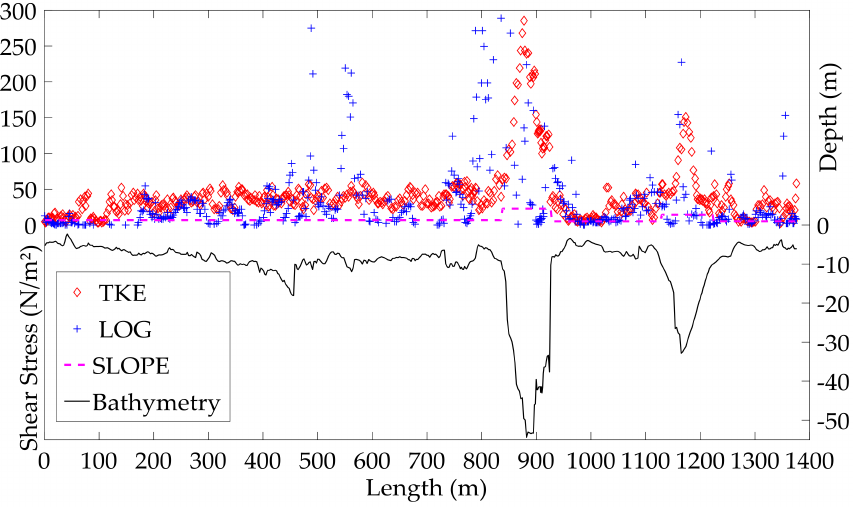
Figure 8. Bed shear stress distribution along the cross-section, using the TKE method, the log-law method, and the depth–slope product